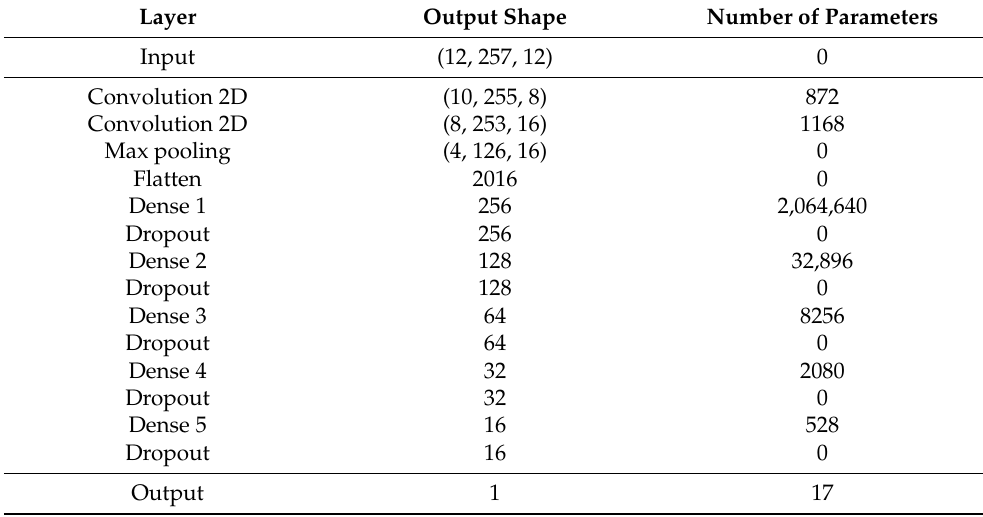
Table A1. Details of the CNN architecture considering both feet (12